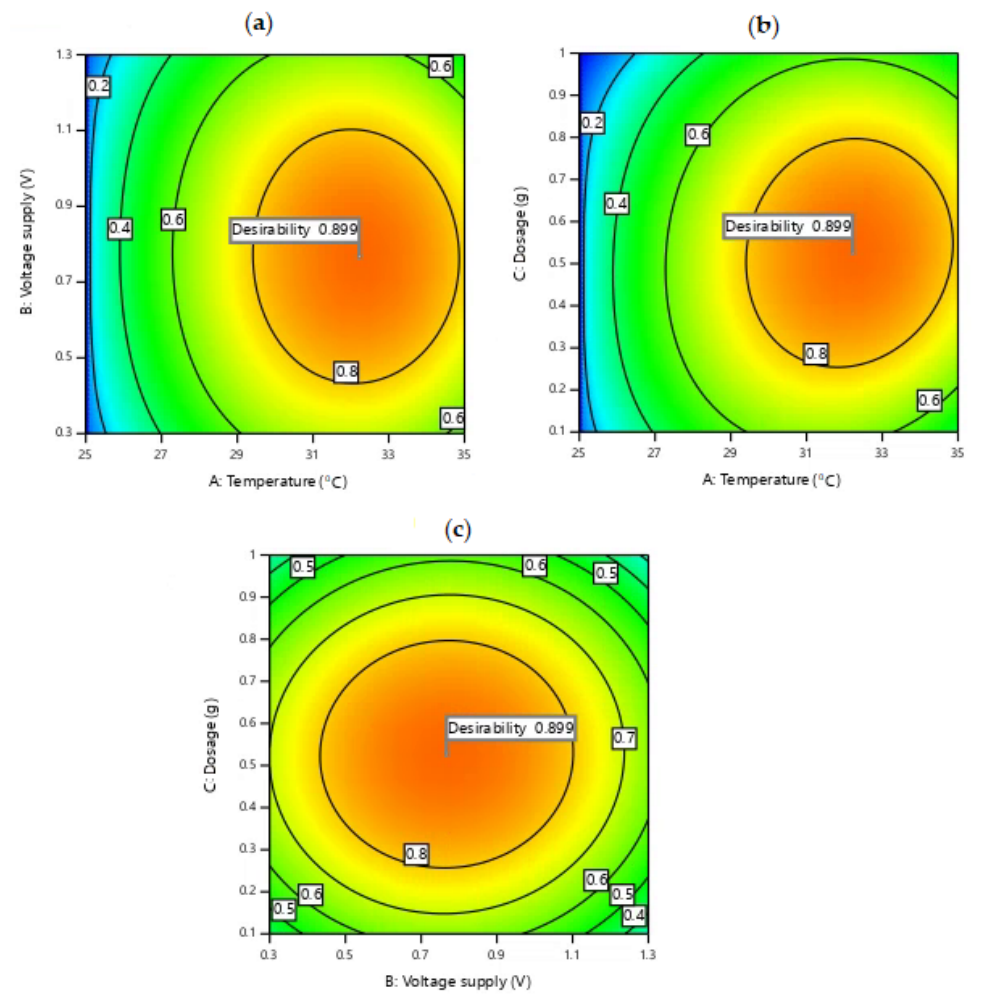
Figure 7. Contour plots depicting the response surface of desirability performance in terms of oper- ating conditions: ( a ) BA; ( b ) CA; and ( c )